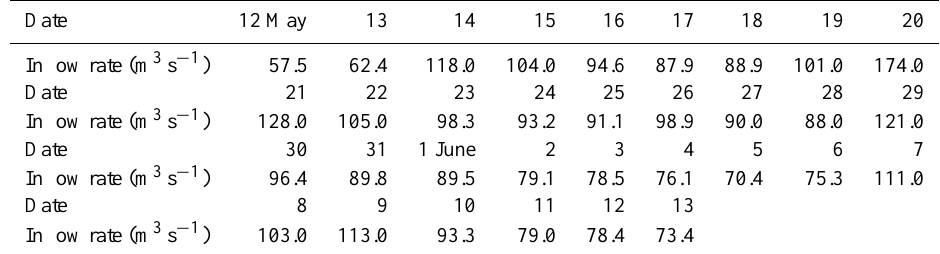
Table 3. A recorded time series of inflow rate into the Tangjiashan landslide lake (Data from Zhang, 2009).